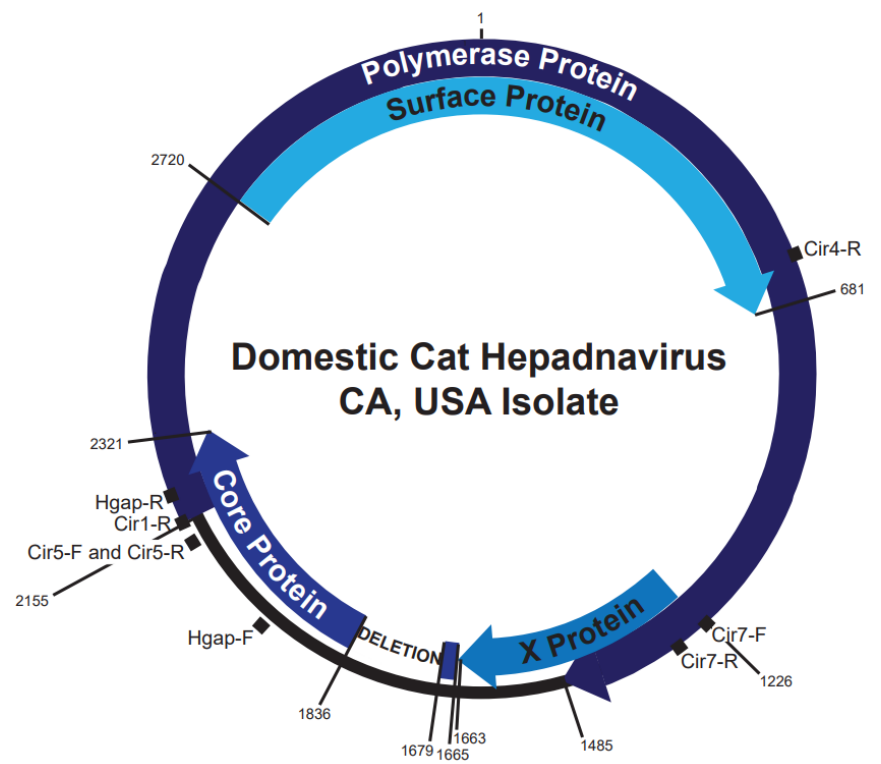
Figure 2. Whole genome DCH from a U.S. domestic cat. Overlapping clones were amplified from a cat from Ventura County, CA, USA. Sequences were aligned to the Sydney DCH reference sequence MH307930. A 157 bp deletion was observed in the core protein open reading frame between nucleotides 1679 and 1836. Multiple primer pairs and clones overlapping this region consistently detected the deletion. Nucleotide 1 represents a conserved EcoR1 site. Conventional PCR binding sites are